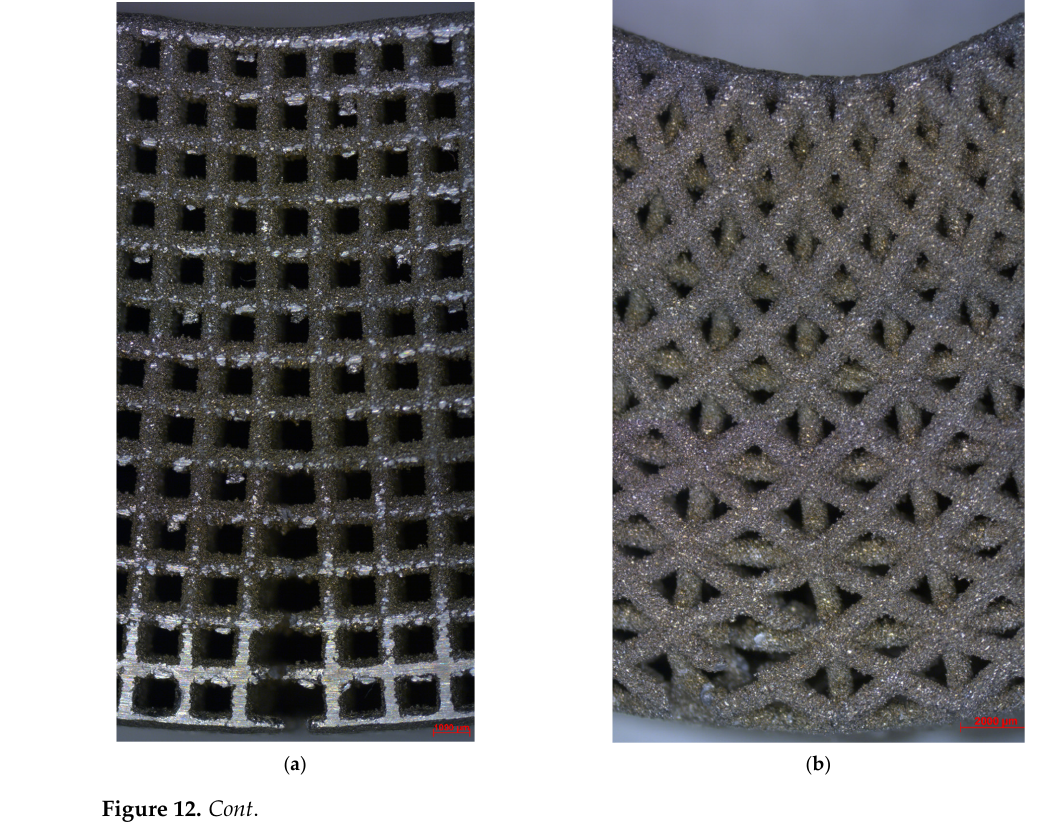
( d ) Figure 12. Bent specimens: ( a ) cubic (optical microscope), ( b ) diagonal (optical microscope), ( c ) cubic (SEM), and ( d ) diagonal (SEM).